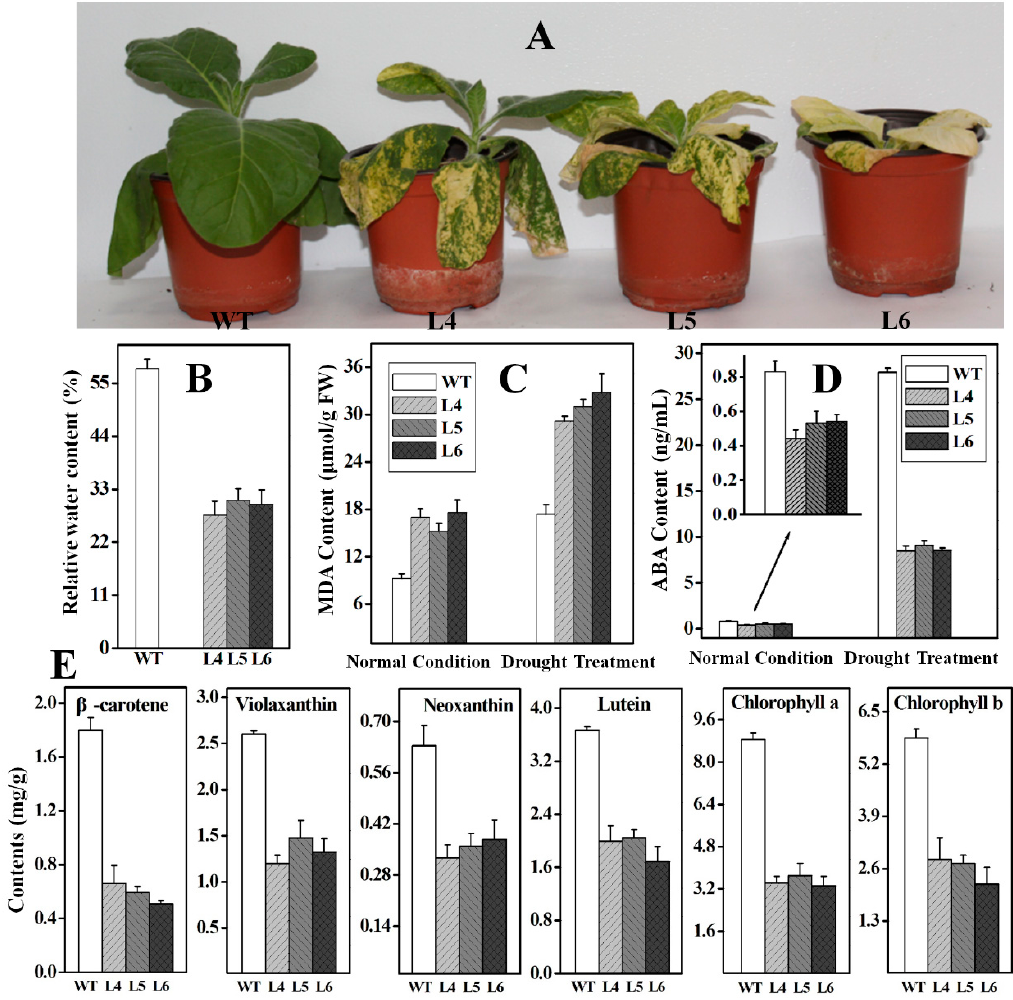
Figure 10. Effects of drought stress on Nt β -LCY1 RNAi transgenic plants. ( A ) Phenotypes of WT and Nt β -LCY1 RNAi plants under drought stress for eight days; ( B ) Relative water content in WT and RNAi plant leaves after drought treatment for two weeks; ( C , D ) Malondialdehyde (MDA) and abscisic acid (ABA) content in leaves of WT and RNAi plants with or without drought stress; ( E ) Carotenoids and chlorophyll content in WT and Nt β -LCY1 RNAi transgenic plants after two weeks of drought treatment. Error bars represent standard deviation ( n = 6). The data presented here are representative of three independent experiments.